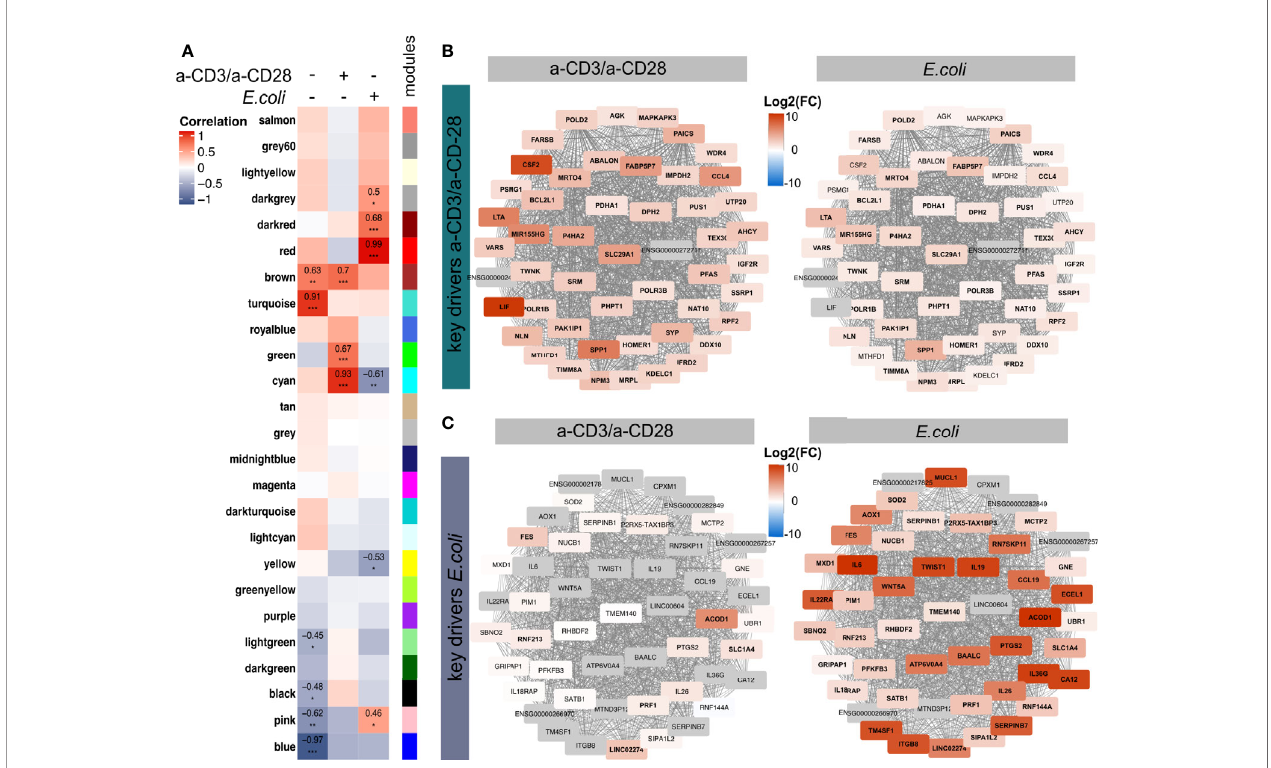
FIGURE 4 | Weighted Gene Correlation Network Analysis of the transcriptome of activated MAIT cells. (A) Module trait correlation plot showing 25 by color-labeled modules, containing co-expressed genes, that were correlated to the three treatments. Correlation coef fi cients were added as numbers and corresponding p-values as asterisks with *** ≤ 0.001, ** ≤ 0.01 and * ≤ 0.05. The top 50 genes with highest intramodular connectivity and gene signi fi cance, re fl ecting putative key drivers (hub genes) for (B) a-CD2/a-CD28 and (C) E. coli -activated MAIT cells, were determined. Log2(FC) of a-CD3/a-CD28 or E.coli -activated MAIT cells compared to unstimulated controls are displayed with signi fi cantly regulated genes (p.adj ≤ 0.01) in bold. Genes in grey were only quanti fi ed in activated samples, thus Log2(FC) is not